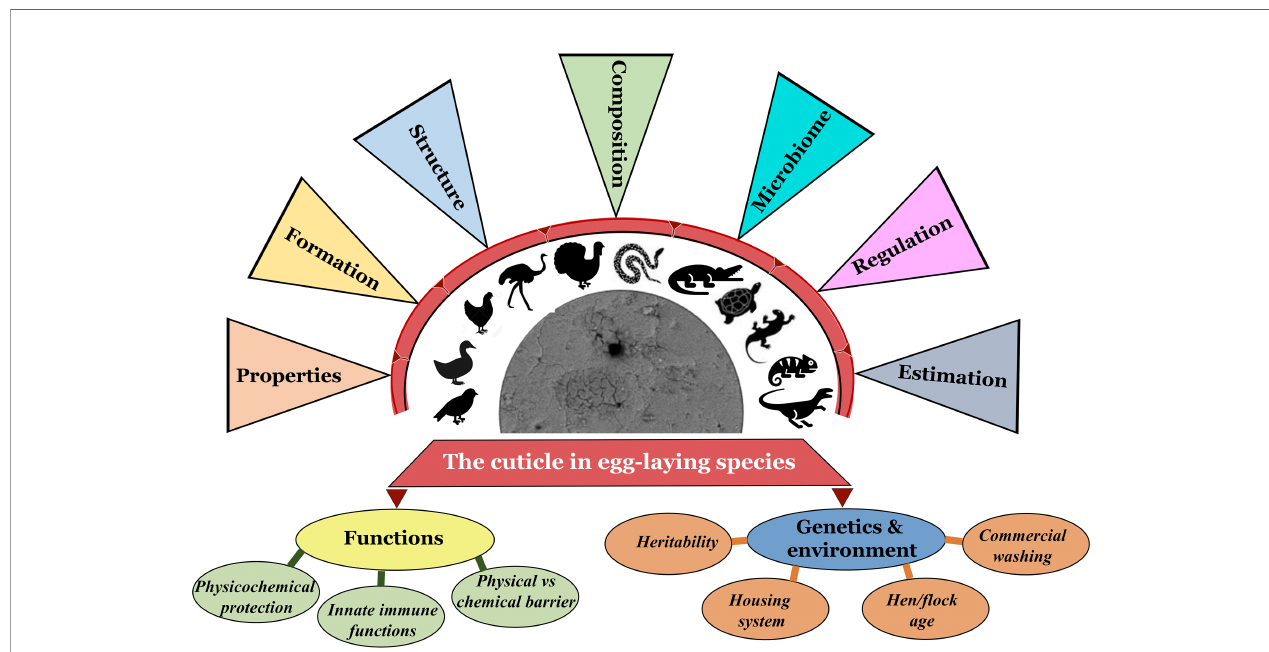
FIGURE 1 | Graphical abstract navigating/cataloging the contents of this review article (Original fi gure by